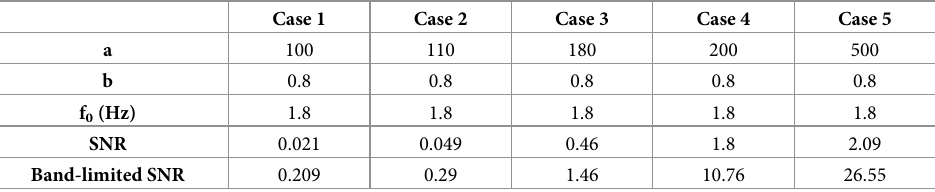
Table 3. Details of parameters used to generate synthetic